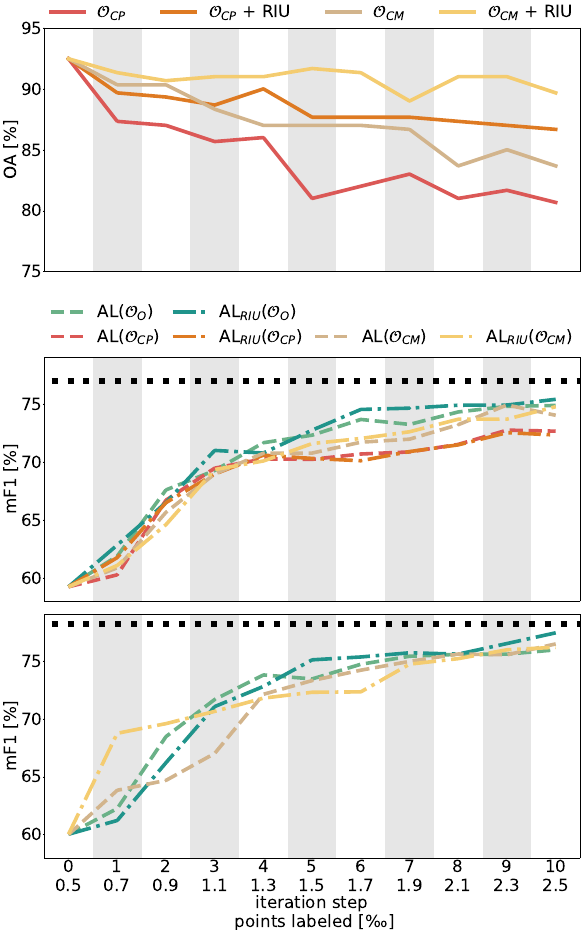
Figure 4. Comparison of the performance of the RF model re- garding the point cloud ( middle ) and the mesh ( bottom ) for se- mantic segmentation, denoted as AL ( O ) and the accuracies of different oracles O ( top ) serving as input for the classifiers. Dot- ted black lines represent the baseline of each respective PL